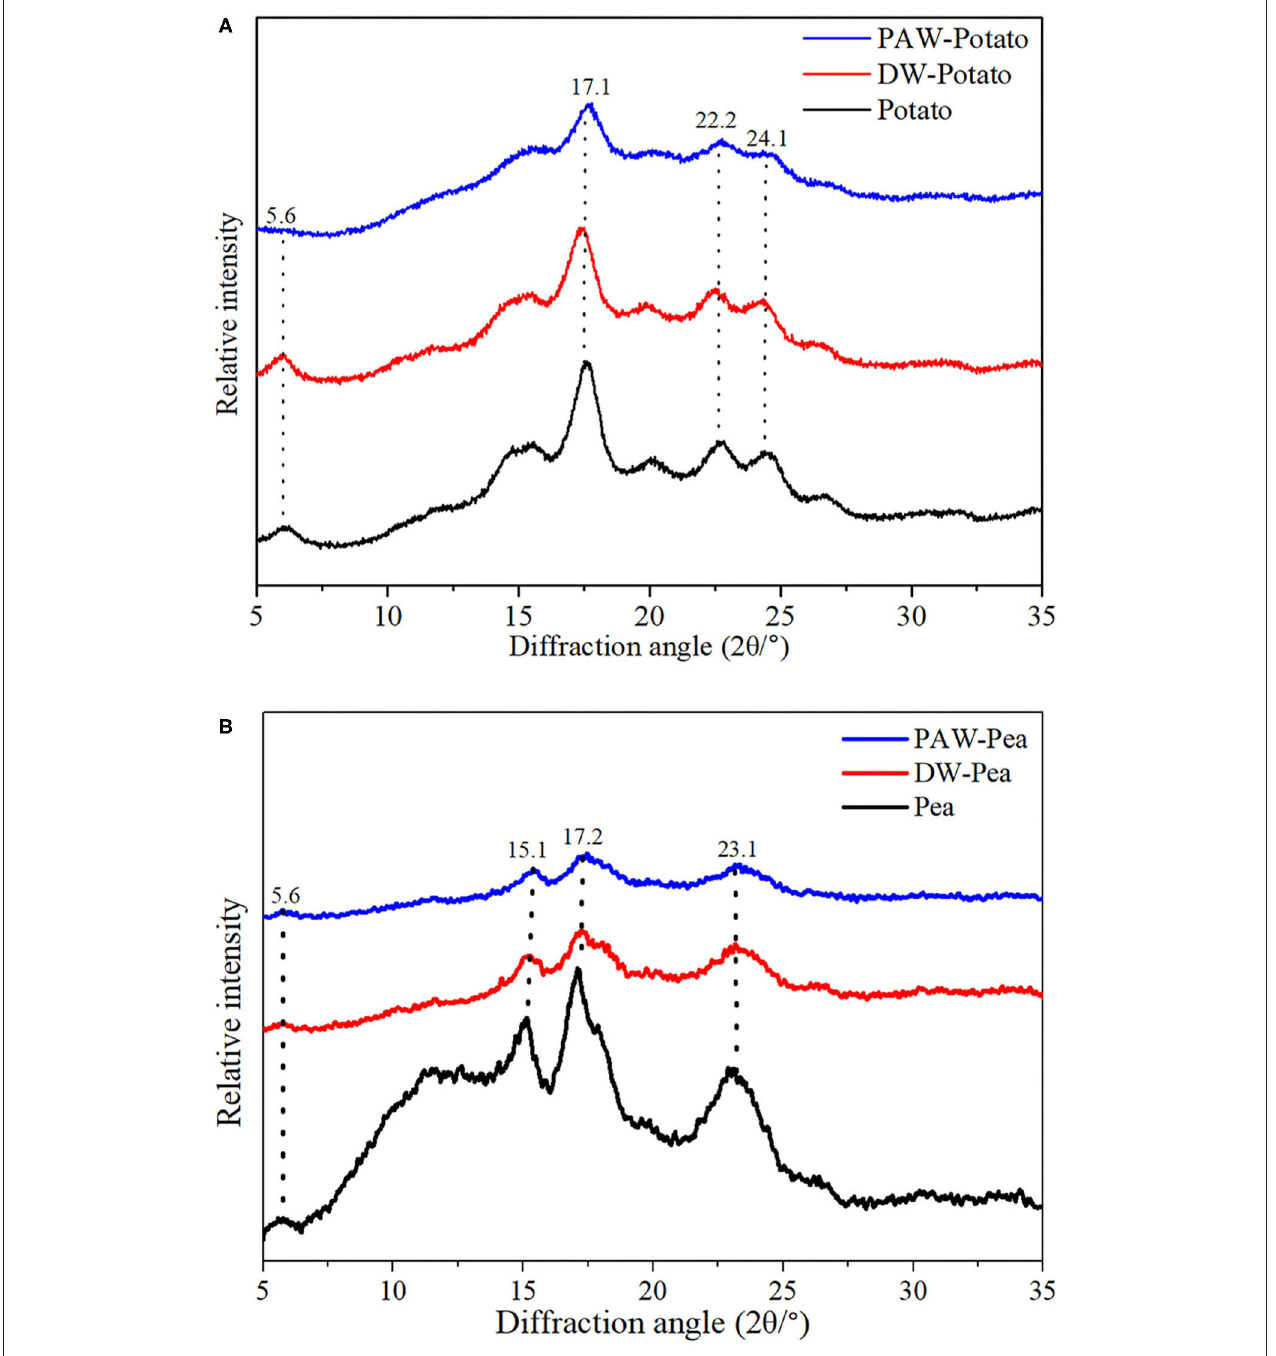
FIGURE 3 | X-ray diffraction (XRD) patterns of native and modified starches. (A) Native, distilled water-annealing (DW-ANN) treated, and plasma-activated water-annealing (PAW-ANN) treated potato starch. (B) Native, DW-ANN treated, and PAW-ANN treated pea starch.